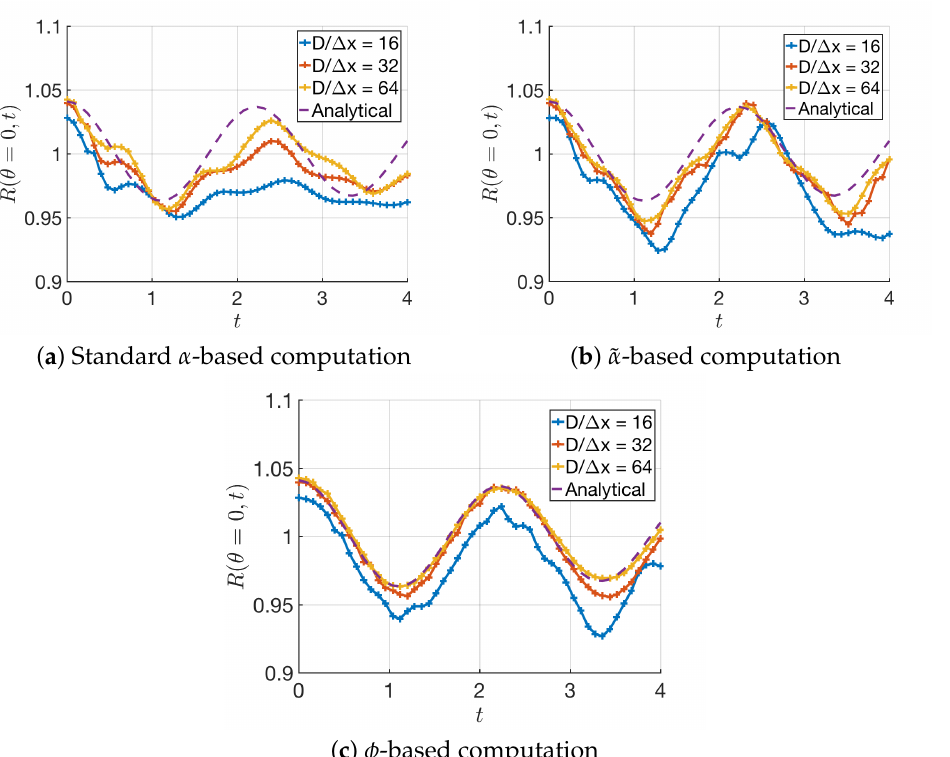
Figure 5. Predictions of the displacement of the interface at the top of the 3D droplet, R ( θ = 0, t ) , employing the three methodologies at different levels of numerical